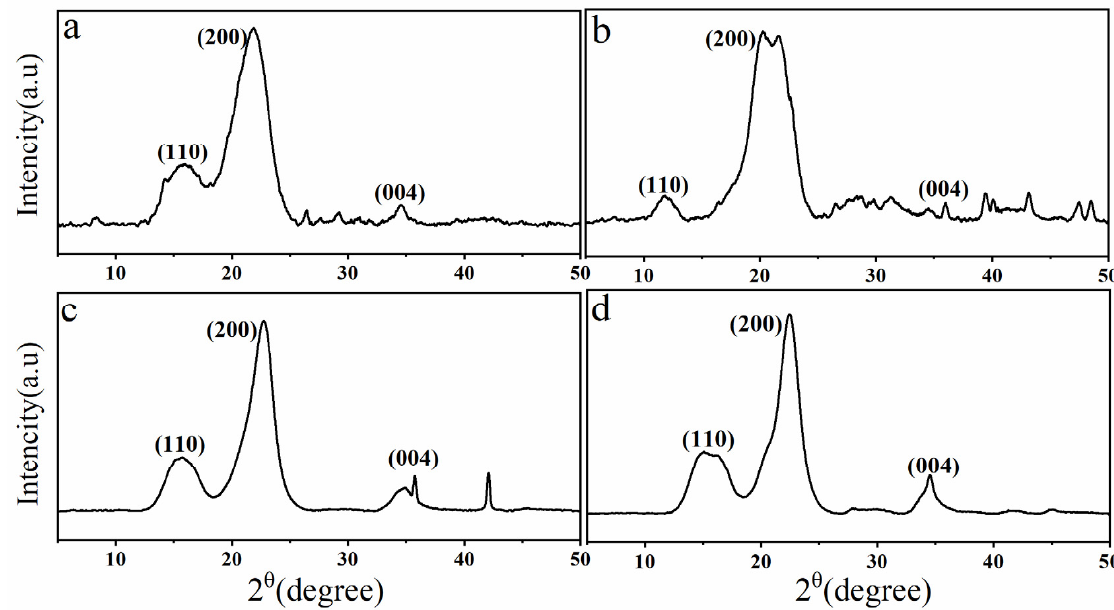
Figure 5. XRD diffractograms of ( a ) DPTM, ( b ) delignified DPTM, ( c ) cellulose and ( d ) NC.